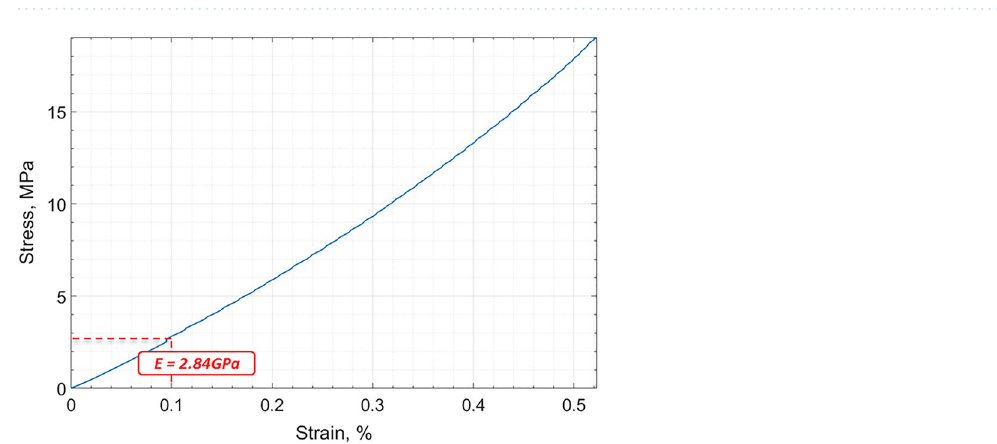
Figure 9. Frequency response function of graphene-oxide foil (h = 35 µm, a = 0.0254 m, ρ = 1800 kg/m 3 ), and mode shape (i = 0, j = 1) measured by laser-vibrometer rig.